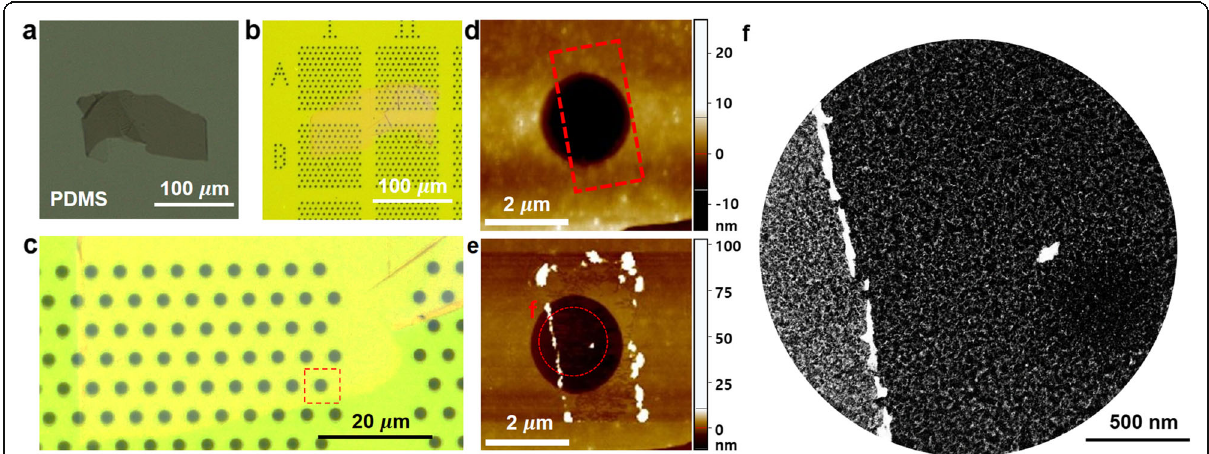
Fig. 2 AFM and TEM investigation of mechanical cleaning of graphene surface residues. a Optical microscope image of a graphene flake exfoliated on the PDMS film. b Graphene flake transferred on a holey Si 3 N 4 membrane TEM grid. c Close-up optical image. The hole in the dashed square was used for AFM scanning shown in panel ( d ). d AFM topography image of the as-prepared graphene near a hole in the Si 3 N 4 membrane. The red dashed box indicates the AFM sweeping area. e AFM topography image obtained after the mechanical cleaning process. The dashed circle is the field of view of the STEM imaging shown in panel ( f ). f HAADF-STEM image of the partially cleaned graphene